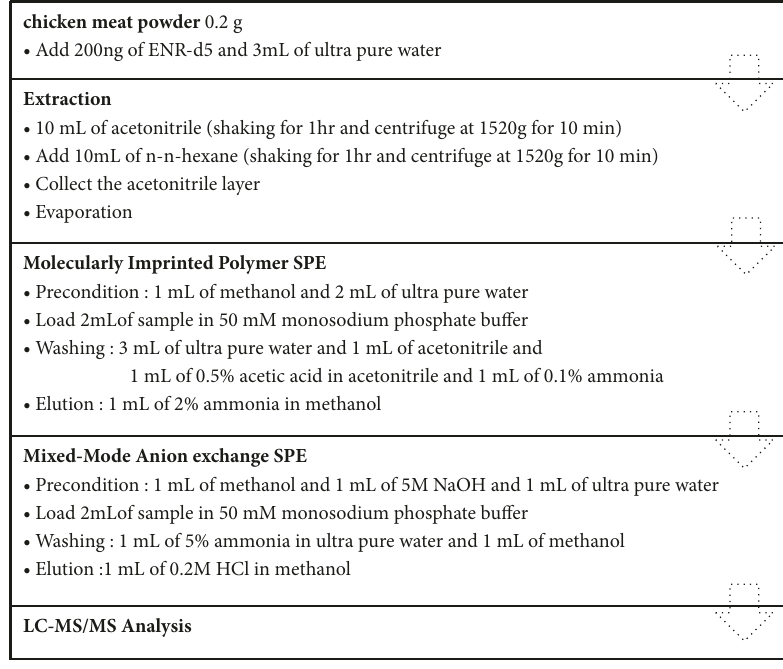
Figure 1: Analytical procedure for the determination of enrofloxacin in chicken